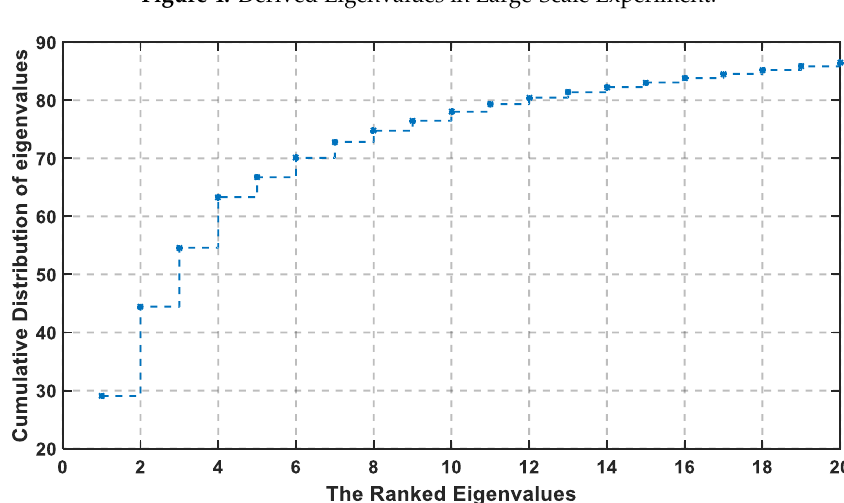
Figure 5. Cumulative Distribution of the Eigenvalues Versus the Number of PCs U in Large-Scale Experiment .